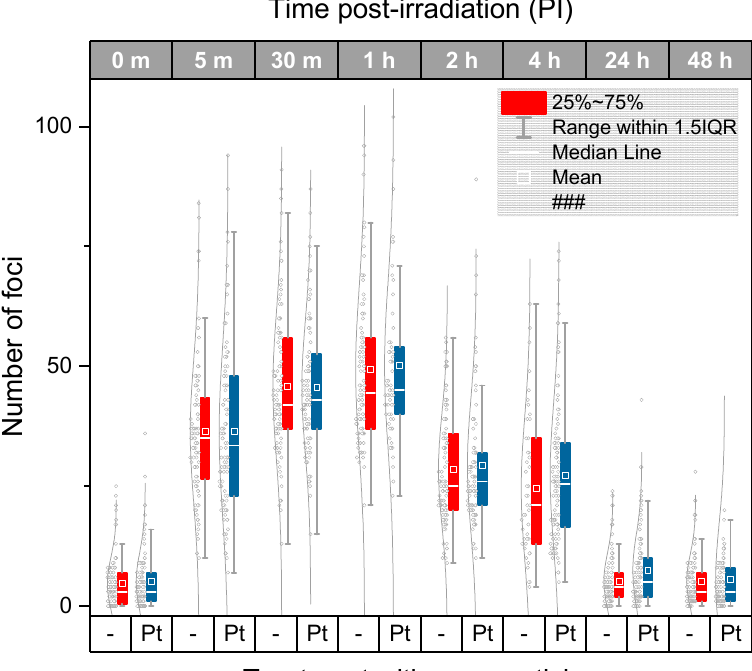
Figure 3. Manual analysis of the extent of γ H2AX+53BP1 focus (DSB) induction and repair kinetics in U87 glioblastoma cells irradiated with 4 Gy of γ -rays compared with cells treated (0.5 mM for 6 h) and not treated prior to irradiation with 2.6 nm platinum nanoparticles (Pt-NPs). The average and median numbers of co-localized γ H2AX + 53BP1 repair foci (i.e., DSBs) per nucleus are shown for different periods of time PI, together with the focus number distributions in each cell population. The boxes include 50% of the values (25th to 75th percentile) centered on the median (the horizontal line through the box). The mean values are represented by the squares within the boxes. The outliers were identified according to the 1.5*IQR method (IQR = interquartile range). Pt—samples treated with platinum nanoparticles, m—the period of time after irradiation in minutes, 0 m—non-irradiated samples.